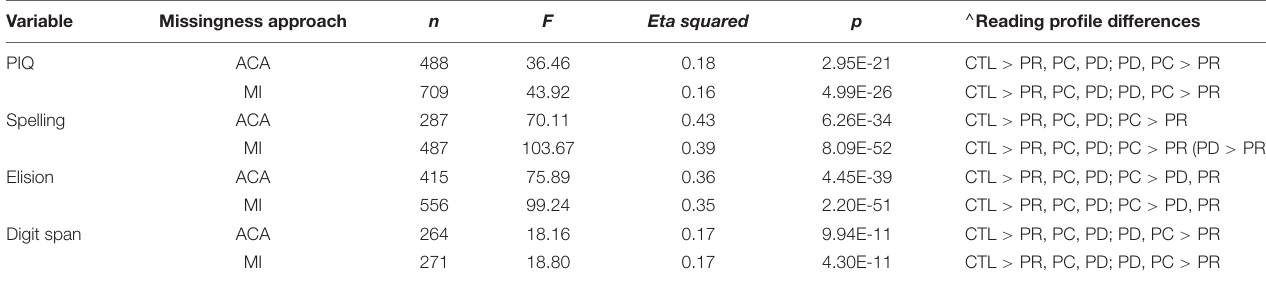
TABLE 2 | Reading profile differences were observed for complete case (ACA) and multiply imputed (MI) data for behavioral measures that were not used to classify the reading profiles.